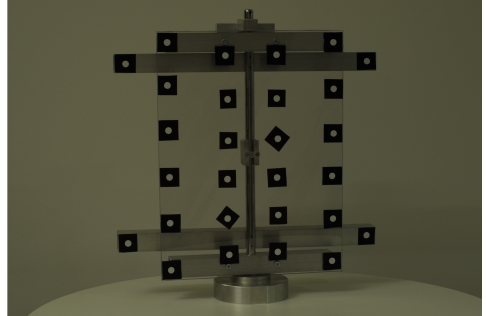
Figure 4. The plate being monitored with four cameras.